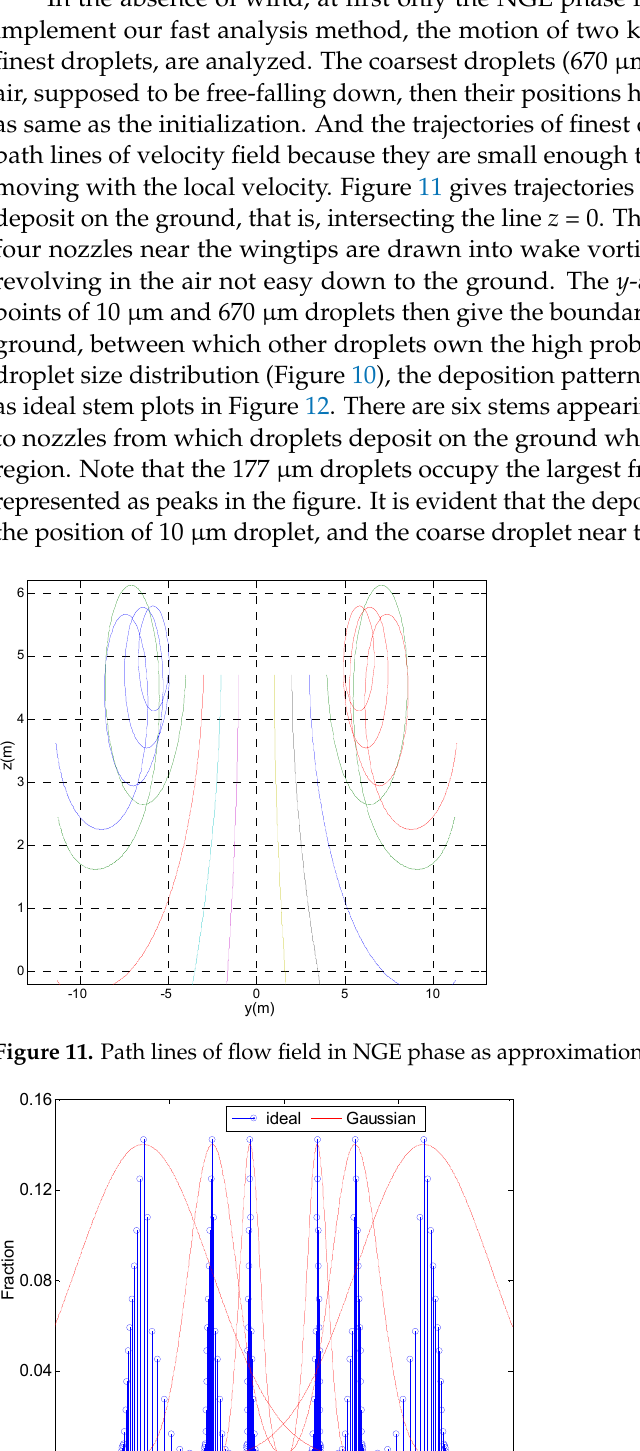
Figure 12. Ideal deposition from each nozzle and their dispersal estimated by Gaussian distribution.